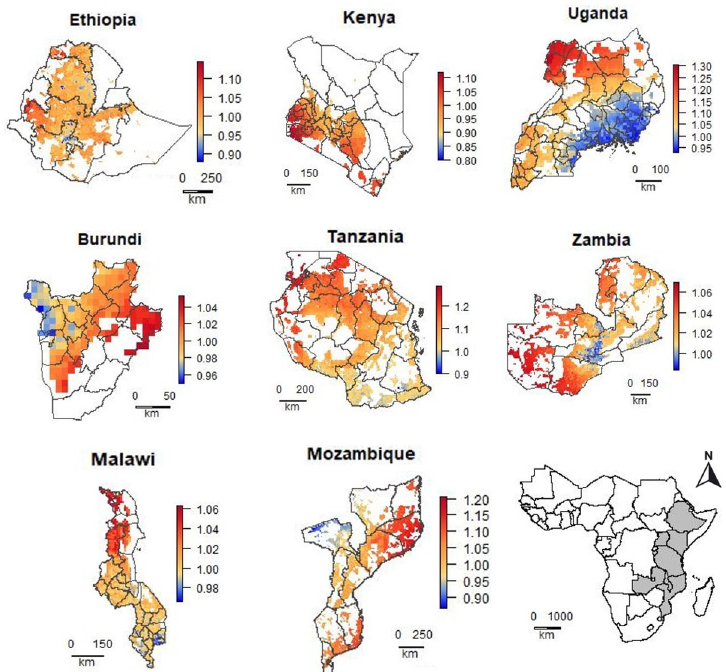
Fig 5. Predicted relative urea price of urea (local price divided by the observed median national price) for areas with crop land in eight East African countries. For Malawi, the prediction of the best-performing model is shown (Africa Fertilizer). For Tanzania, the prediction of the combined model (Africa fertilizer and LSMS) is